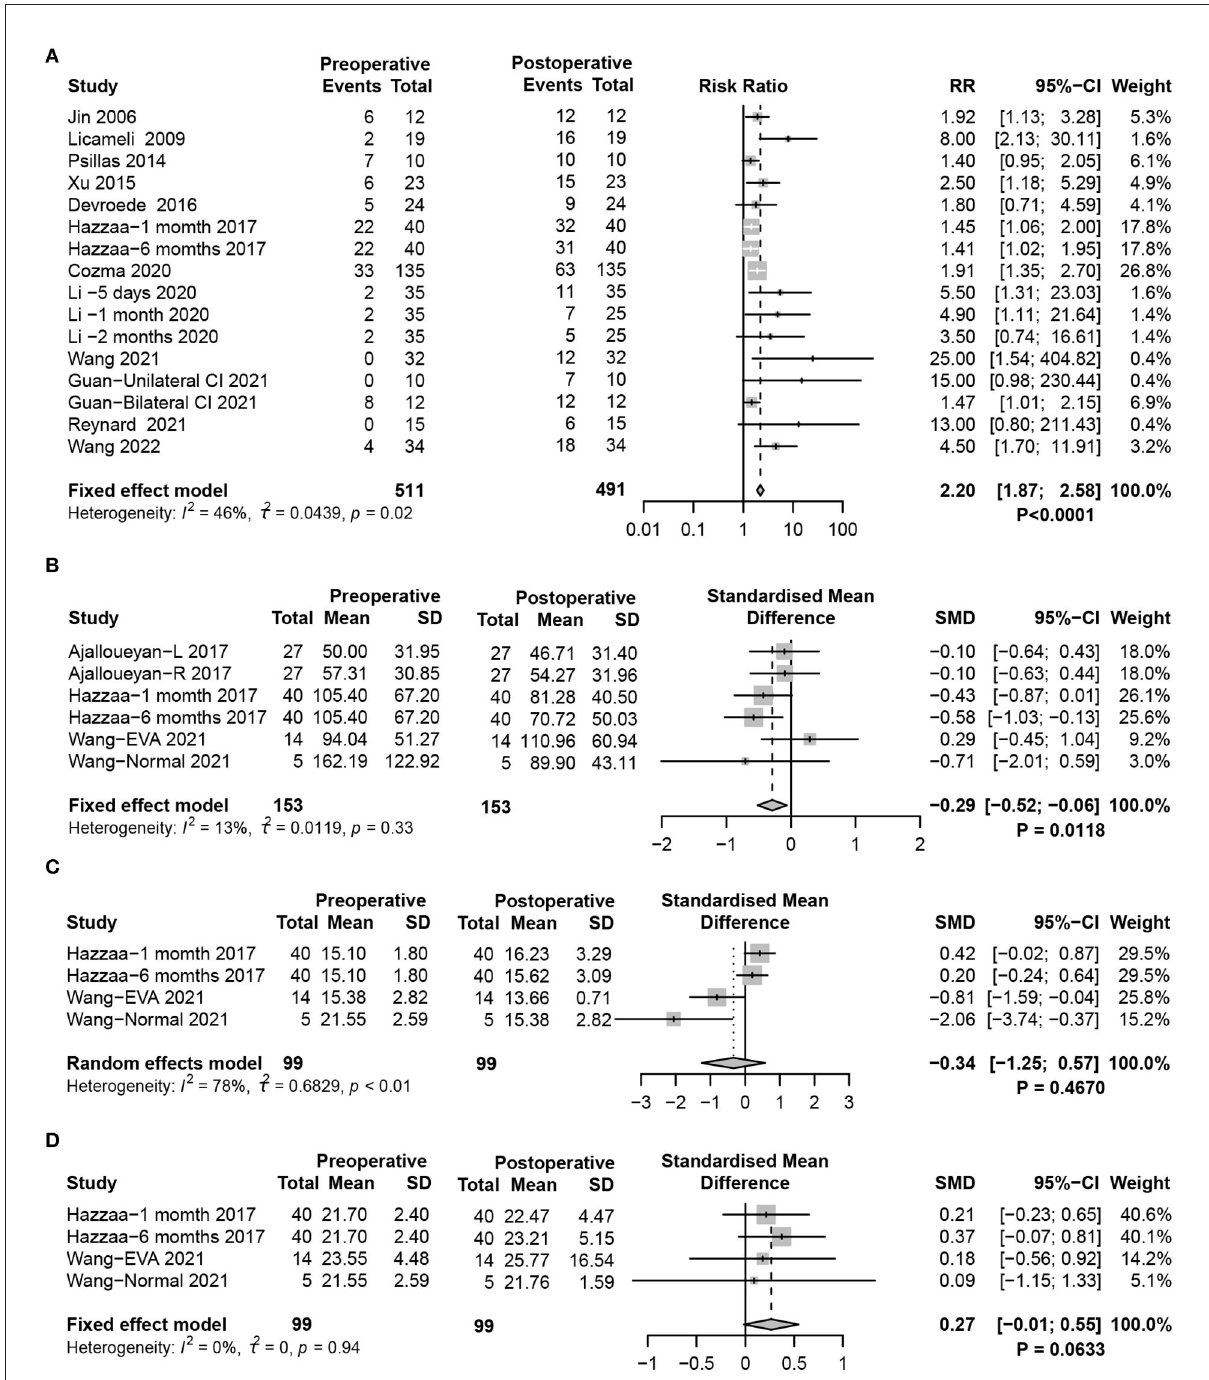
FIGURE2 Forest plots showing the saccular function test results between pre- and post-surgery groups. (A) Response to the cVEMP test. (B–D) Response of cVEMP parameters including (B) P1-N1 amplitude, (C) P1 latency, and (D) N1 latency. Study, included studies for Research on meta-analysis; Preoperative, results of vestibular function test before operation; Postoperative, results of vestibular function test after operation; Events, number of people with abnormal vestibular function test results; Total, total number of patients in the study; Mean, arithmetic mean; SD, standard deviation; RR, relative risk; 95%-CI, 95% confidence interval; SMD, standardized mean difference; Weight, weight of each study in